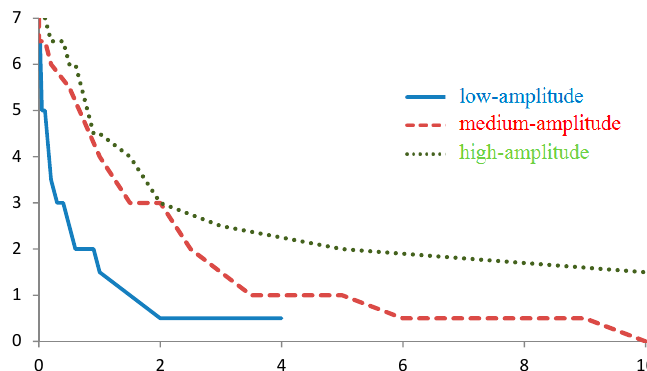
Figure 8. Dependence of the number N true of the correctly found route points on the measurement error (E) for a route containing 7 points when navigating using the intersection of five independent components of the gravity tensor. Regions with low-, medium-, and high-amplitude gravity anomalies.